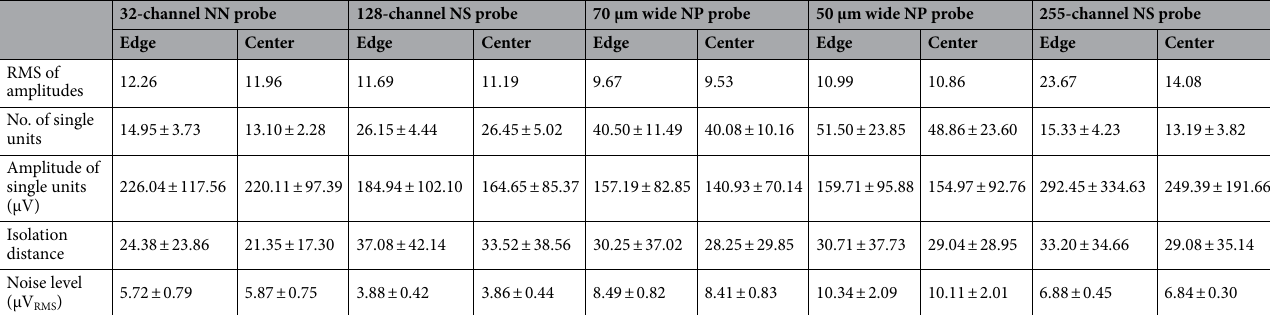
Table 2. Mean ± standard deviation of the calculated features for all probe types (NN, NeuroNexus; NS, NeuroSeeker; NP, Neuropixels). The root mean square (RMS) of amplitudes was calculated by pooling samples of all recordings.